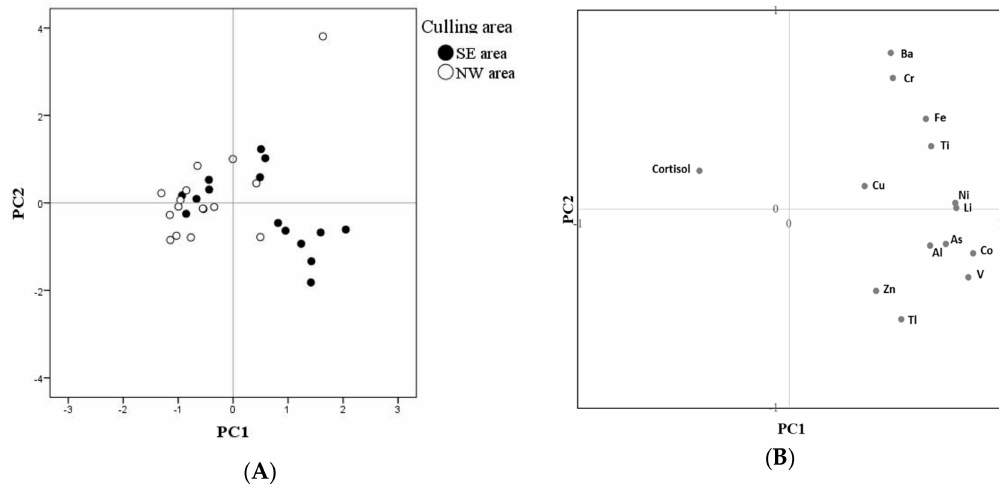
Figure 3. Principal component analysis (PCA) results on the first two principal components (PC1: 41.63% of explained variance; PC2: 15.13% of explained variance). ( A ) Score plot, representing the location on the first two principal components of each sample, classed depending on the culling area: South-East (SE) or North-West (NW); ( B ) loadings plot, representing the weight of each variable on the first two principal